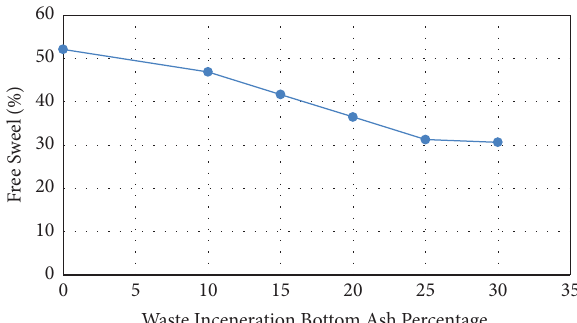
Figure 3: Efect of waste incineration bottom ash on the free swell index of